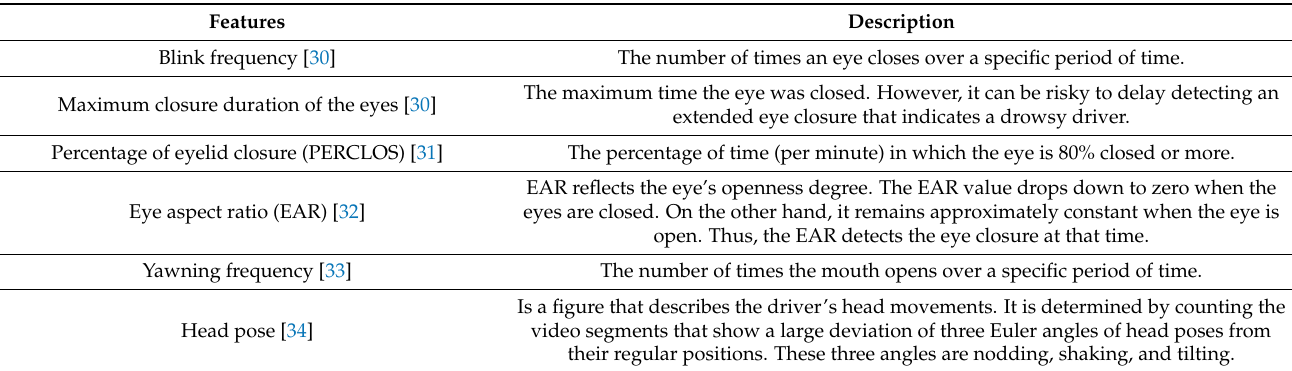
Table 3. Some of the image-based